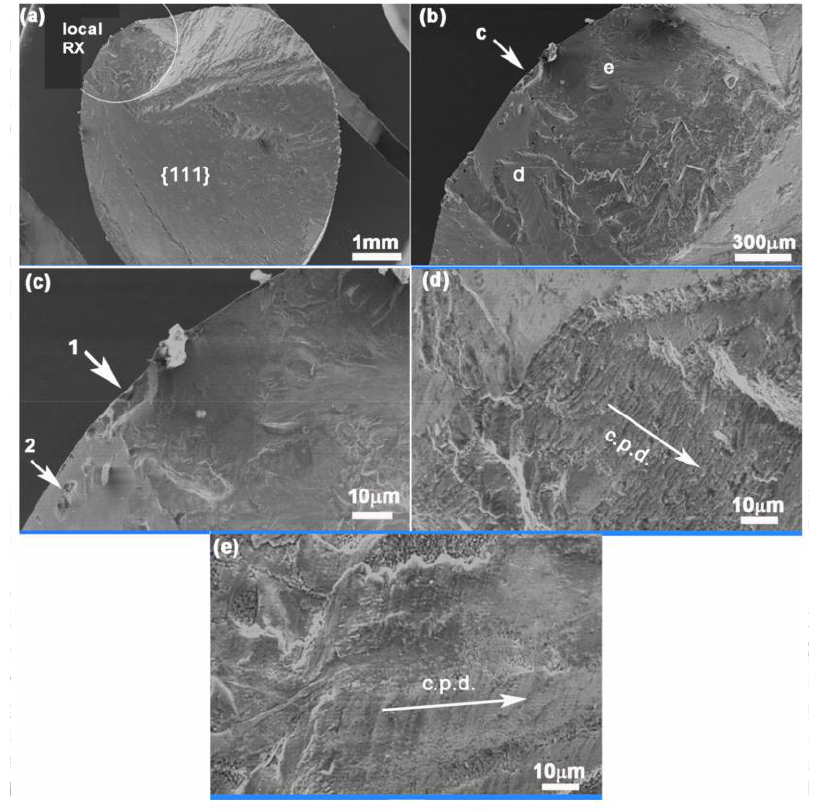
Figure 7. Fracture surface of a single crystal alloy with local recrystallization at 550 ◦ C ( N f = 2757 cycles); ( a ) overall fracture surface; ( b ) crack intiation and propagation region; ( c ) crack initiation site; ( d ) crack propagation behavior at site ‘d’; ( e ) crack propagation behavior at site